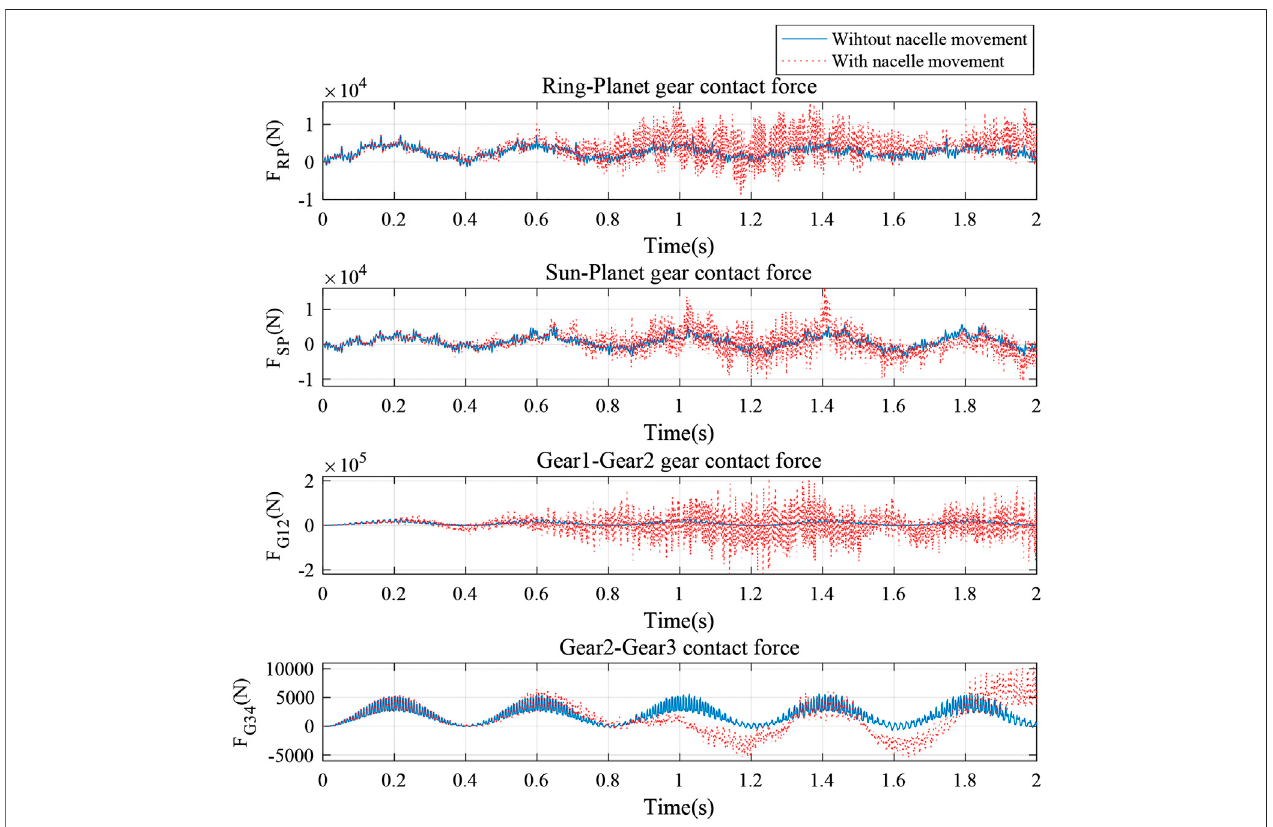
FIGURE 12 | Gear mesh contact force in the nacelle movement